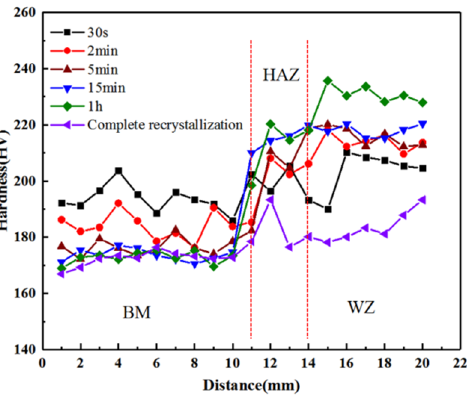
Figure 18 . Hardness distribution of welded joints under different heat treatment time.